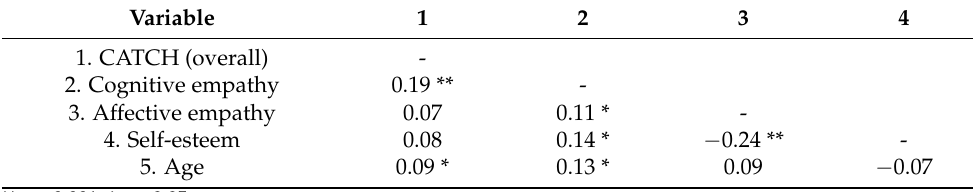
Table 3. Zero-order correlations between the main variables ( N =